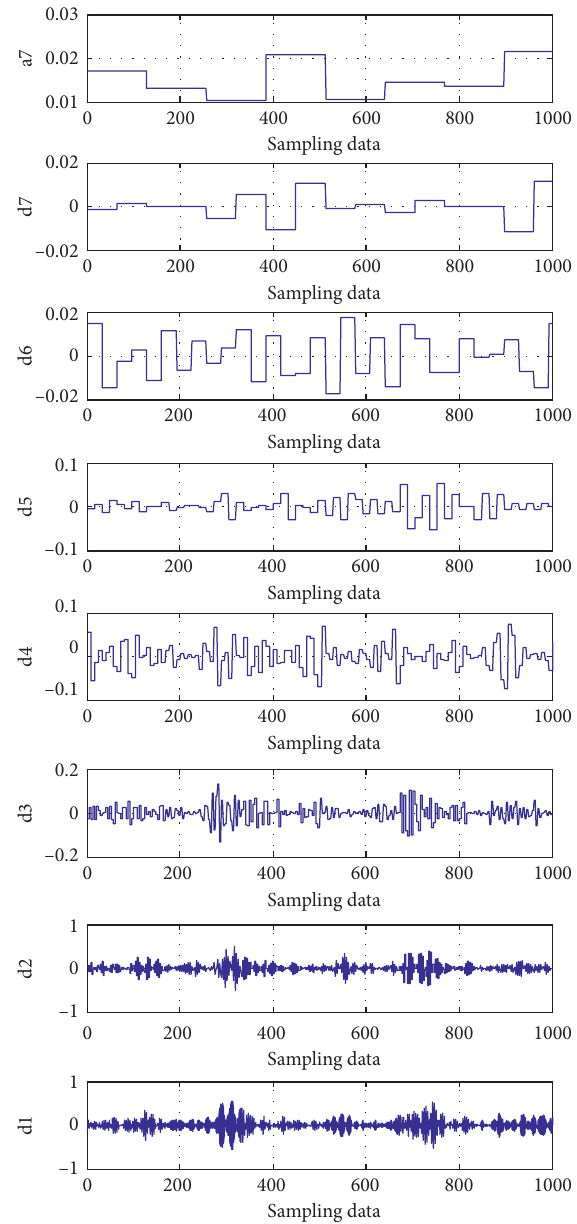
Figure 3: The decomposition signal of motor bearing based on the dual tree complex wavelet